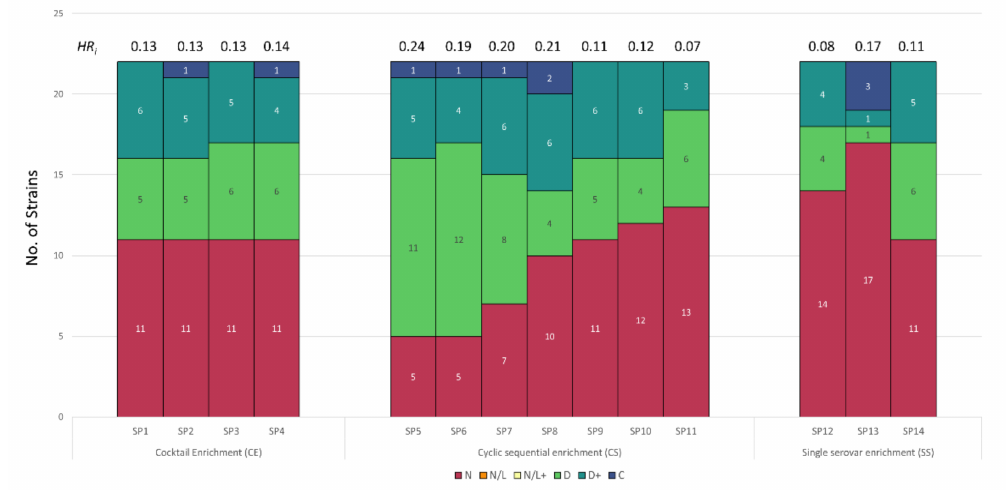
Figure 5. Stacked bar plot showing the host range of Salmonella phages isolated using different enrichment methods. Designation: C, complete inhibition, D+, >5 h delay to reach exponential phase; D, <5 h delay to reach exponential phase; N, no effect; HR i , host range index.